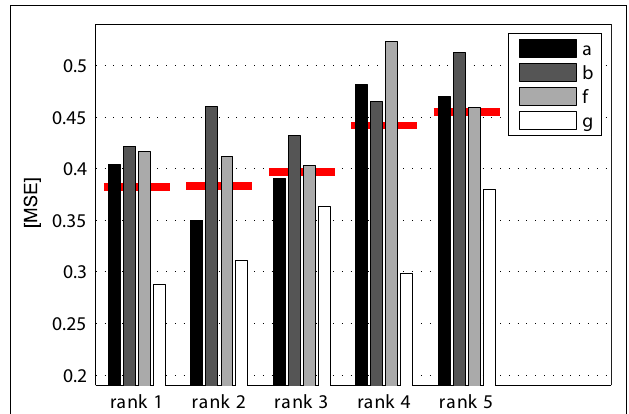
FIGURE 5 | (Data set 1 – histogram of results). Performance of the first five ranked submissions is shown in terms of their mean squared error (MSE) wrt. the true labels. Only results for the real (i.e., not artificially generated) data sets are shown.The mean across the four data sets is plotted as a horizontal red line.The MSE for constant prediction output of 0 are 0.507, 0.515, 0.491, 0.524 for data sets a , b , f , g , respectively.